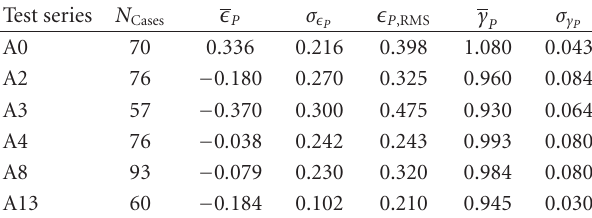
Table 9: Accuracy of steady-state DNB bundle